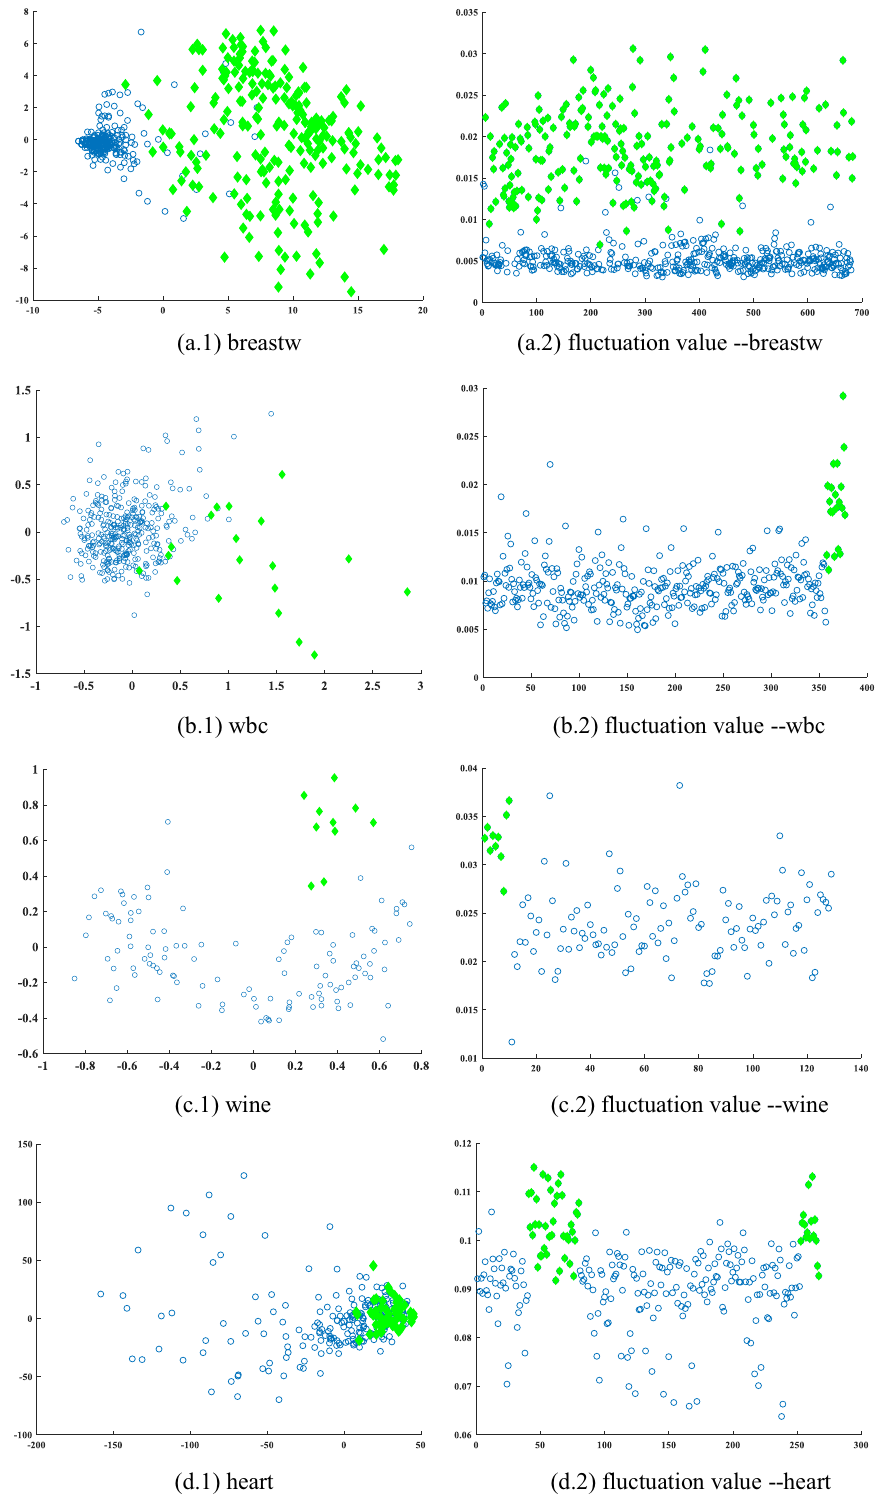
Figure 7. The original data distribution after PCA dimensionality reduction. The blue hollow circles represent normal objects, the green solid diamonds represent the true outliers in each dataset (left) and fluctuation values of each object in datasets, and the green solid diamonds represent the fluctuation values of true outliers in each dataset